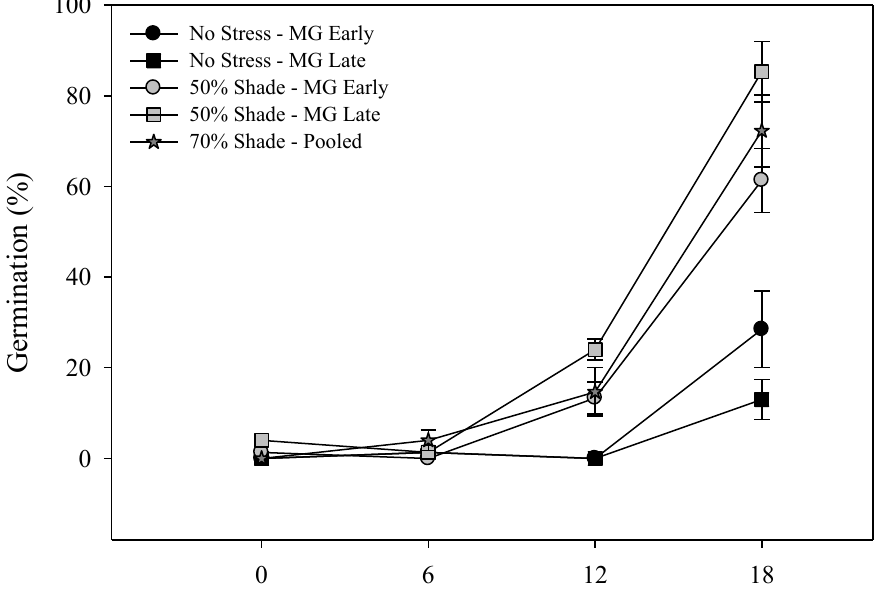
Figure 2. Germination of M73 wild oat seed from the 2006 grow-out from plants grown under high light (nostress) and shaded conditions after being subjected to varying durations of controlled